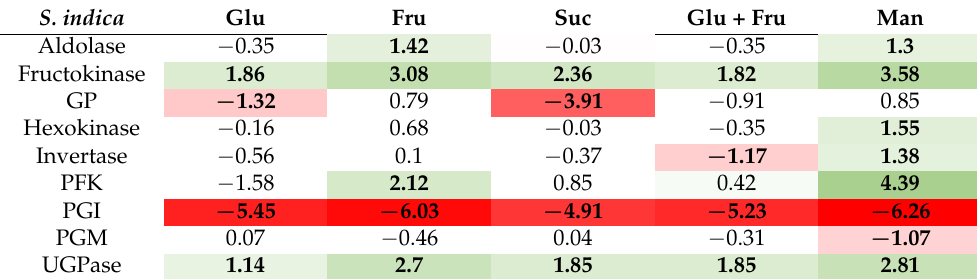
Table 2. Sugar regulation of enzyme activities in the cytosol of S. indica 14 days cultivated in the presence of glucose (Glu), fructose (Fru), sucrose (Suc), an equimolar mix of glucose and fructose (Glu + Fru), mannose (Man) or without sugar. The table shows the M-values (log2 of ratios of values obtained from sugar-treated cultures to values from cultures cultivated without sugar). Values higher than 1 (>2-fold induced) below − 1 (>2-fold repressed) and which are based on significant differences (Tukey HSD test; n = 6) are indicated in bold and color-coded (green: sugar induction; red: sugar repression). Activity of glucose-6-phosphate dehydrogenase was very low and not